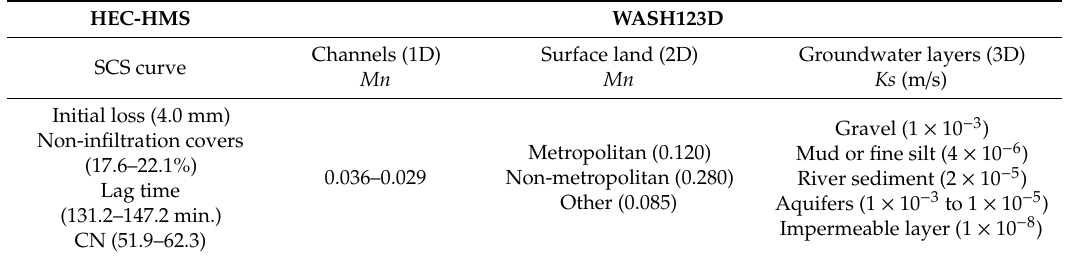
Table 1. Parameters used in the Soil Conservation Service (SCS) curve method and WASH123D of Fengshan Creek basin (extracted from Wu and Shih [7]). CN, curve number.